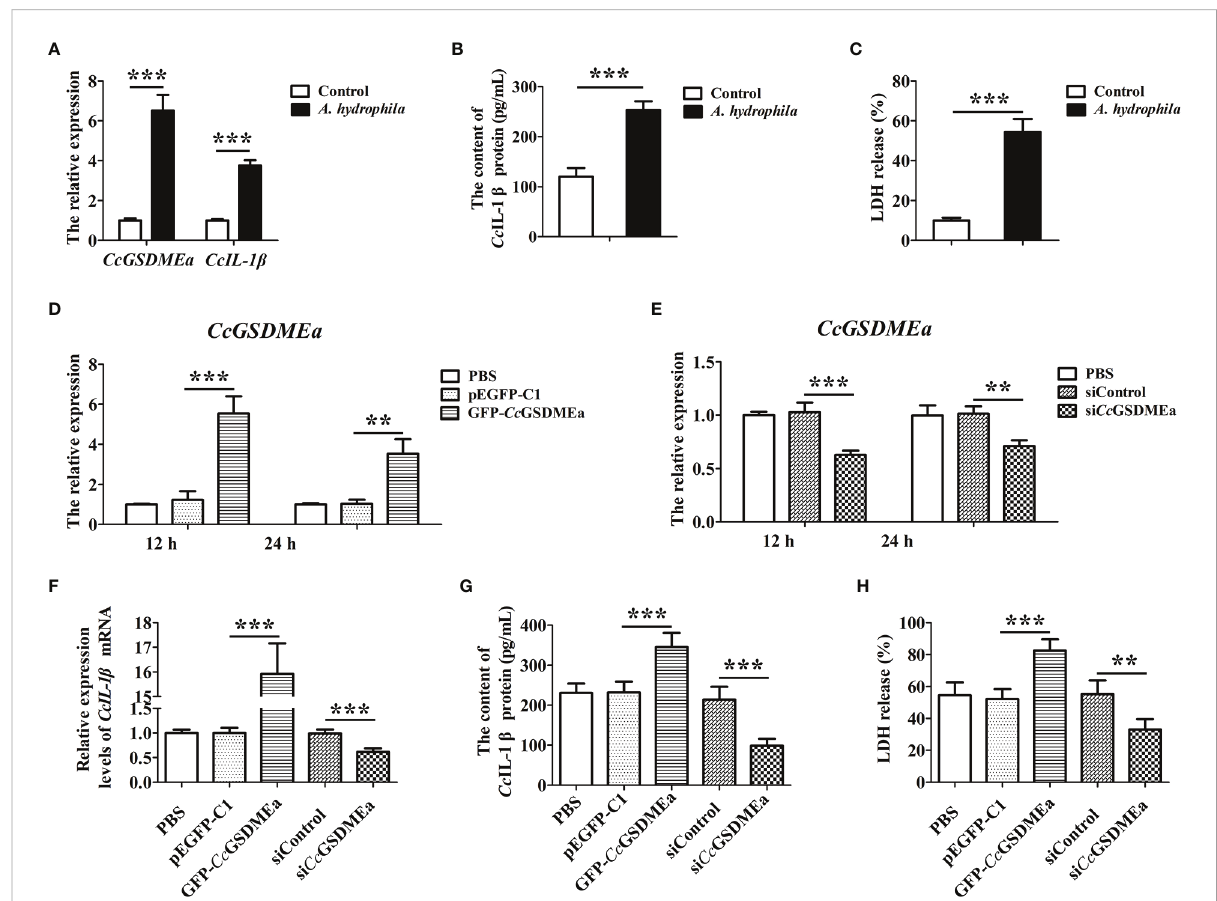
FIGURE 9 Cc GSDMEa promotes the secretion of Cc IL-1 b in vitro . (A) The mRNA expression levels of CcGSDMEa and CcIL-1 b in EPC cells after A. hydrophila challenge. (B) The content of Cc IL-1 b protein in the cell culture medium after A. hydrophila challenge. (C) The LDH release in EPC cells after A. hydrophila challenge. (D, E) The overexpression and knockdown ef fi ciency of Cc GSDMEa in EPC cells at 12 h and 24 h. (F-H) The mRNA expression levels of CcIL-1 b , protein secretion contents of Cc IL-1 b and the LDH release from cells in overexpression or knockdown group after A. hydrophila challenge. The data were expressed as mean ± SD (n = 3). The signi fi cant differences were analyzed using student ’ s t test ( ** , P < 0.01; *** , P <